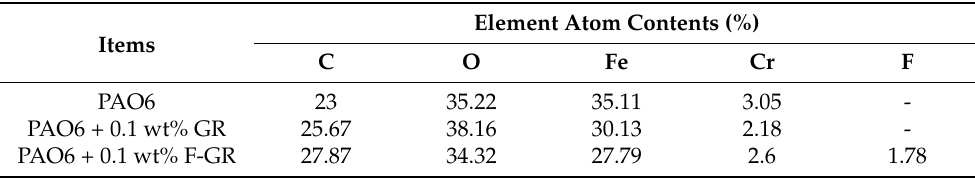
Table 1 studies the atomic element content of disc wear traces of different oil samples when the load is 50 N, 25 mm/s, and the lubrication time is 30 min. The decrease of Fe content indicated that the addition of 0.1 wt% F-GR could effectively form a protective film on the steel plate’s surface to achieve wear resistance and friction reduction Table 1. Element atom contents of wear traces of disks lubricated with different oil samples at load 50 N and 10 mm/s for 60 min.